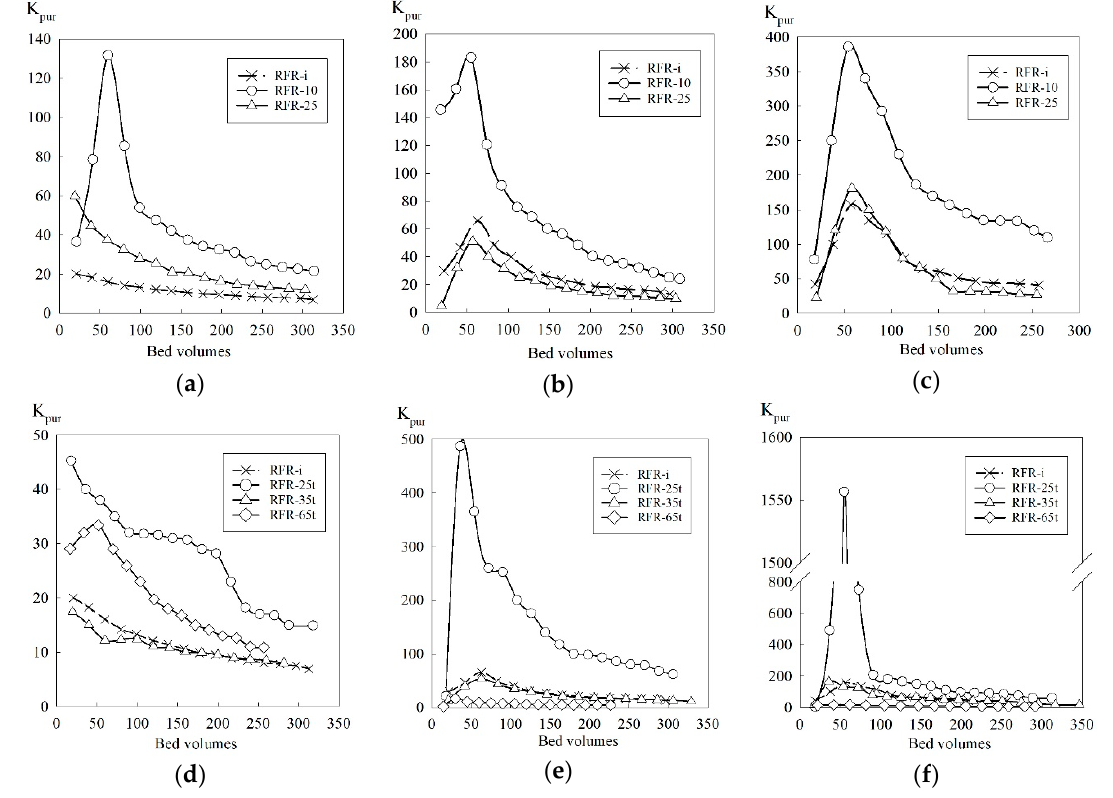
Figure 4. Cs-137 removal from the model solution under dynamic conditions; ( a – c )—first, second, and third sorption cycle of the resins obtained via the first route; ( d – f )—first, second, and third sorption cycle of the resins obtained via the second route.